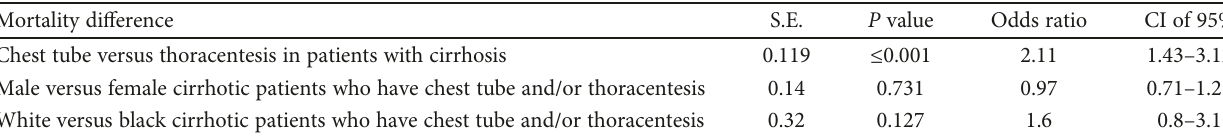
Table 4: Mortality di ff erence and binary logistic